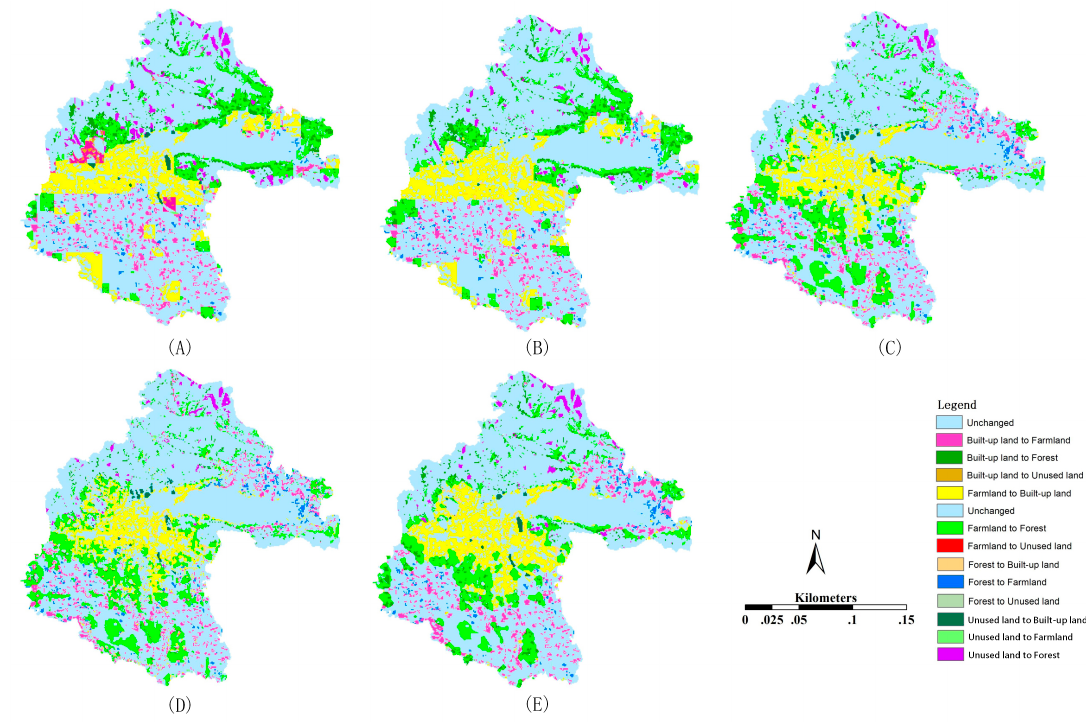
Figure 14. The land conversion in Jixian from 2010–2020 of the five labelled solutions in Figure 12. (A) The land conversion of solution A; (B) The land conversion of solution B; (C) The land conversion of solution C; (D) The land conversion of solution D; (E) The land conversion of solution E.